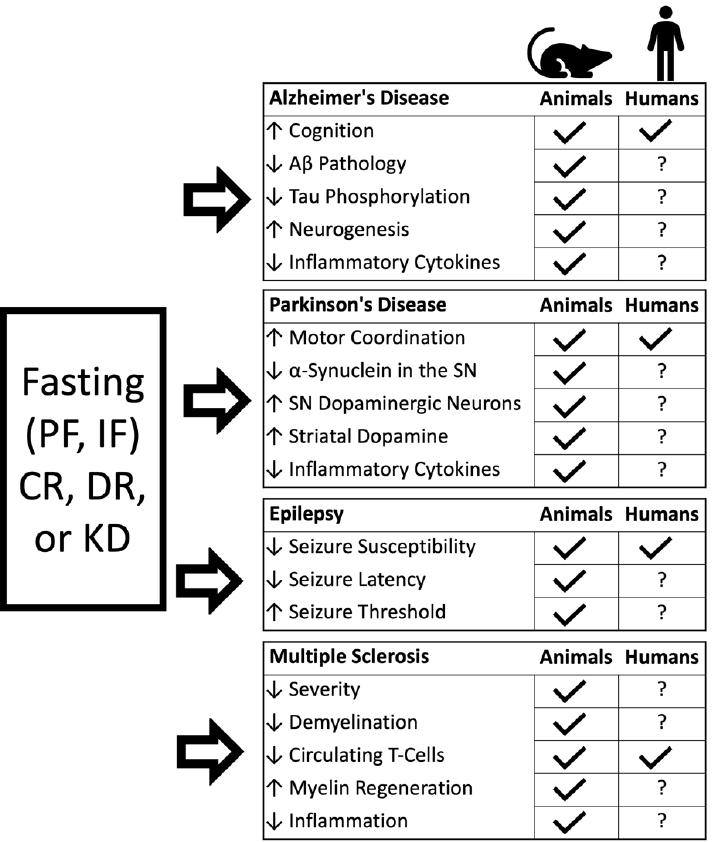
Figure 1. Summary of reviewed findings in animal and human studies of AD, PD, epilepsy, and